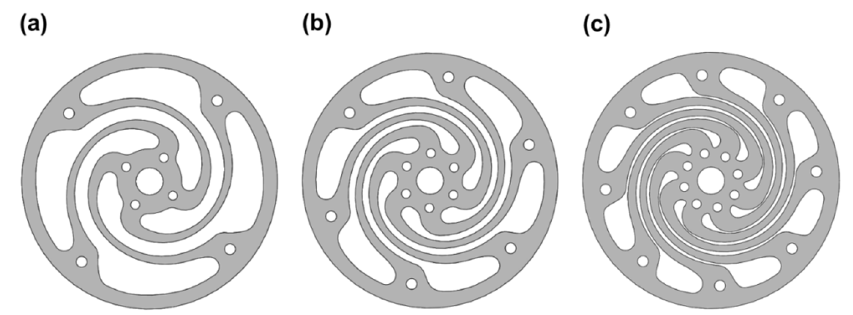
Figure 7. Spring shape according to the number of spiral arms: ( a ) 4, ( b ) 6, and ( c ) 8 spirals.